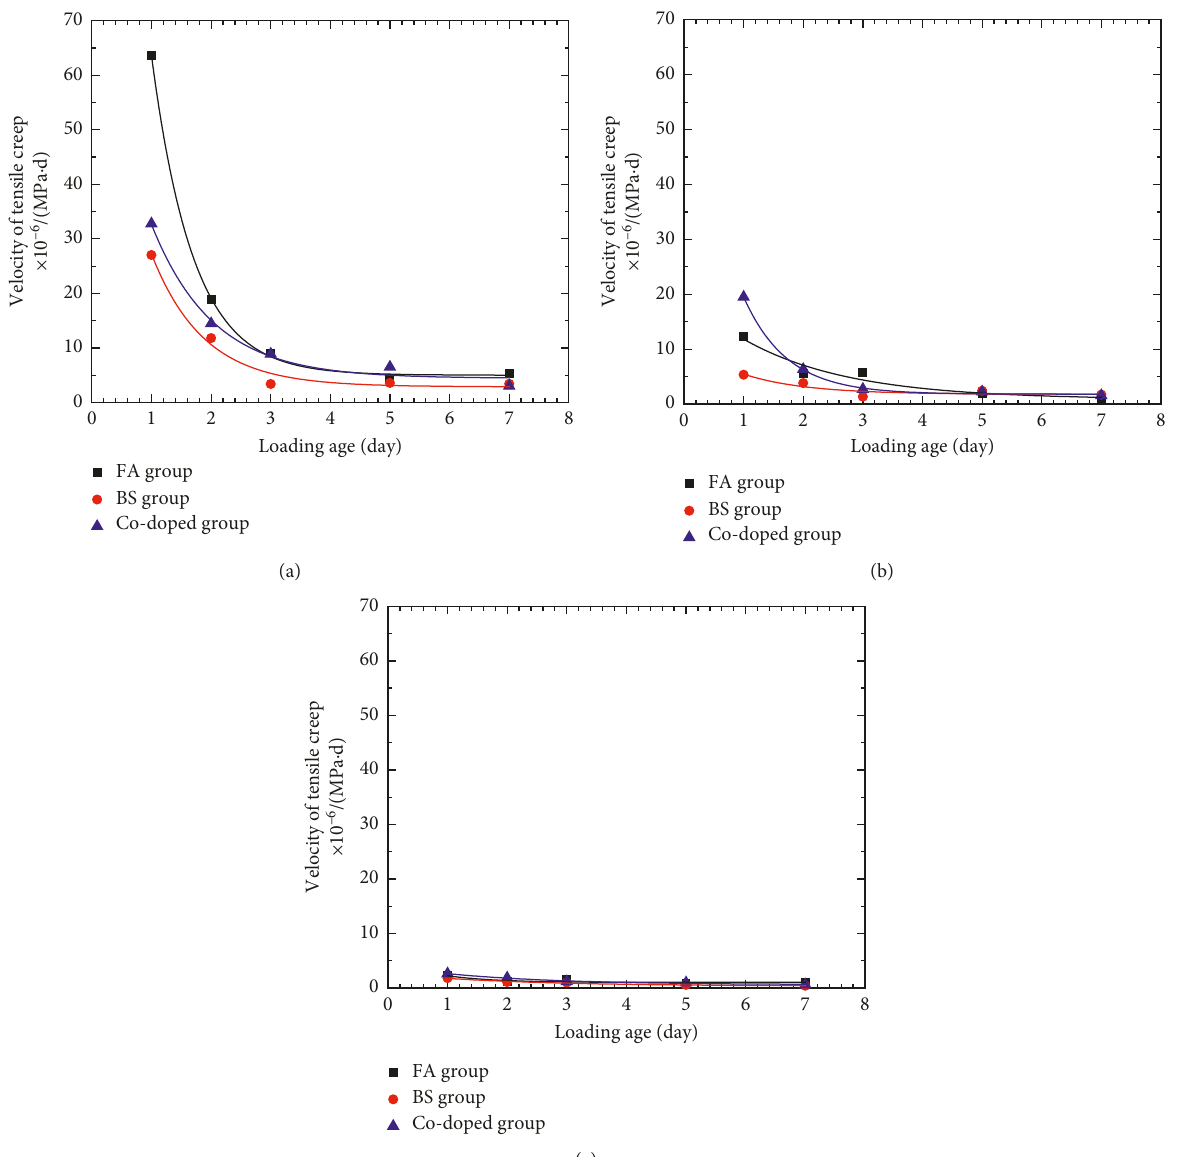
Figure 9: Tensile creep velocity of different loading durations (a) from 0 d to 3 d, (b) from 3 d to 7 d, and (c) from 7 d to unload